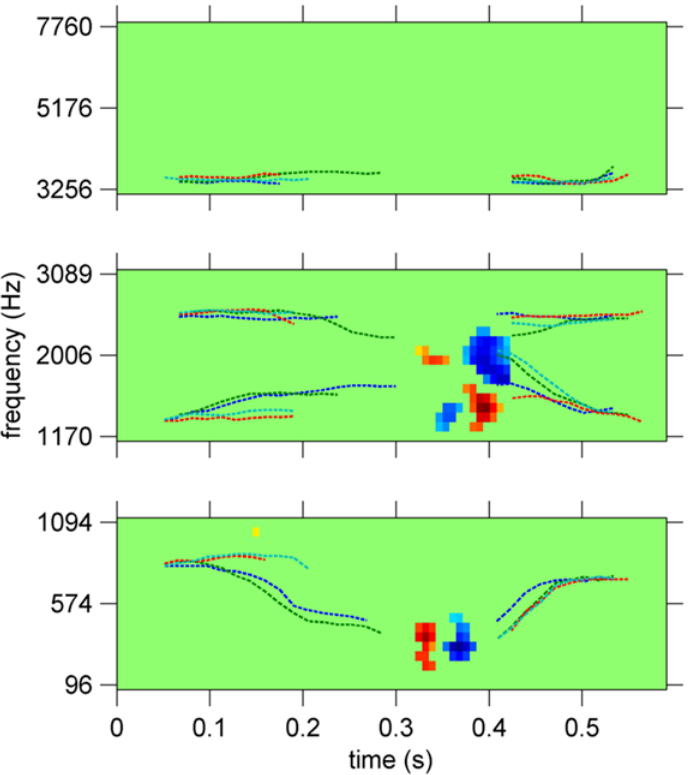
Fig 7. Band-limited ACIs, in low-frequency (90 – 1,100 Hz, l ~ = 36, middle frequency (1,100 – 3,100 Hz, l ~ = 144) and high frequency (3,100 – 8,000 Hz, l ~ = 144) bands. In each band, weights are divided by their maximum absolute value and formant trajectories are superimposed (same legend as in Fig. 6). Non- significant weights are set to 0 (corrected t-test, FDR <